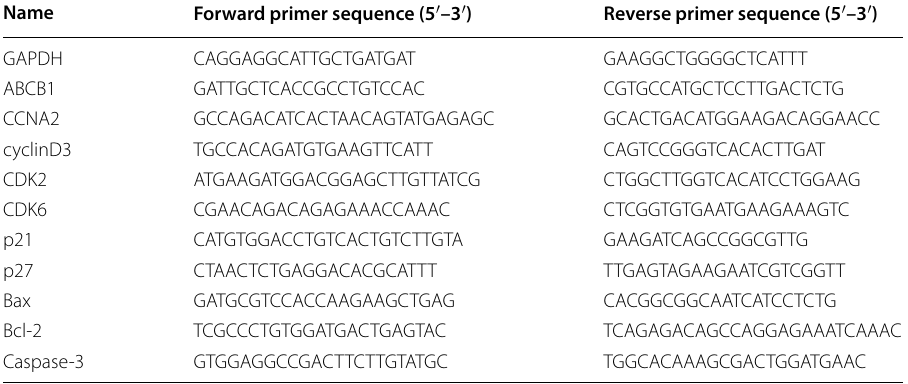
Table 1 Primer sequences for real-time PCR assays Name Forward primer sequence (5 ′ –3 ′ ) Reverse primer sequence (5 ′ –3 ′